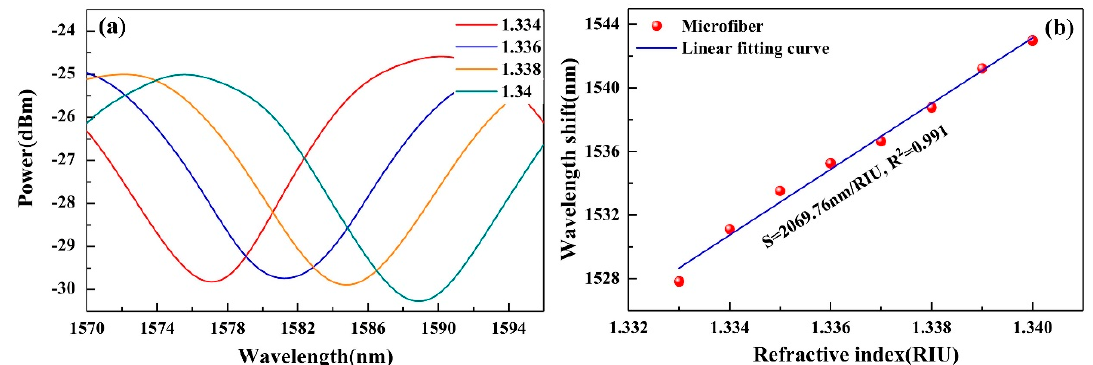
Figure 3. RI sensitivity of the microfiber: ( a ) transmission spectra in different RI solutions and ( b ) relationship between the wavelength shift and the RI.